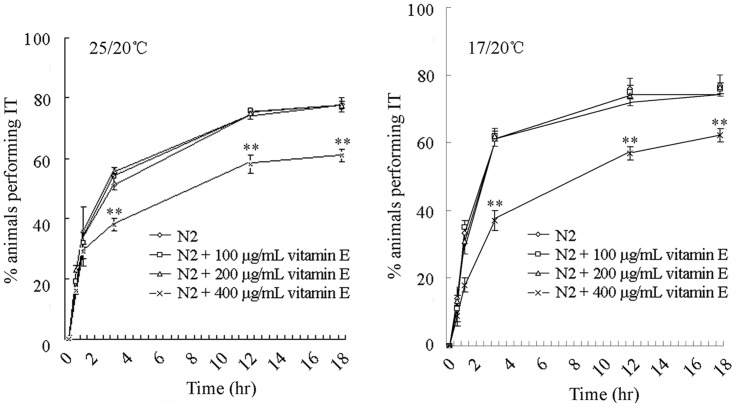
Effects of vitamin E treatment at different concentrations on thermotaxis learning behavior as monitored by 25/20°C or 17/20°C thermotaxis assays in C. elegans.IT, isothermotracking. Data are expressed as mean ± SEM. **p<0.01 vs. N2.